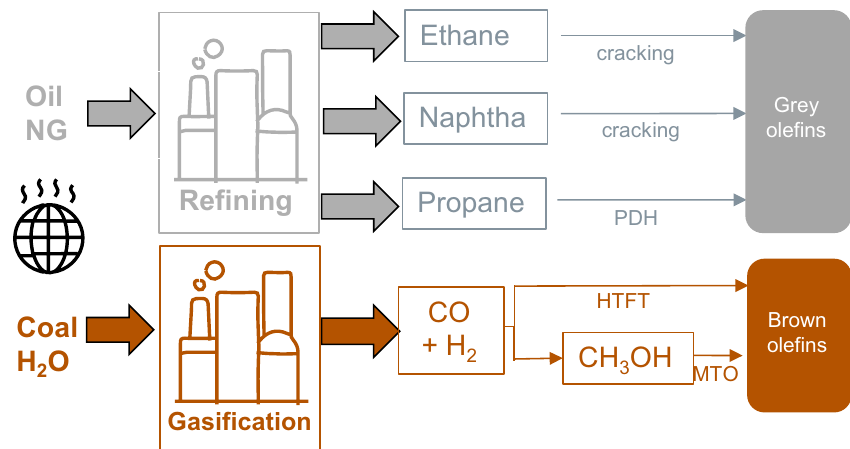
Fig. 2 Principal scheme for fossil-based grey and brown olefin